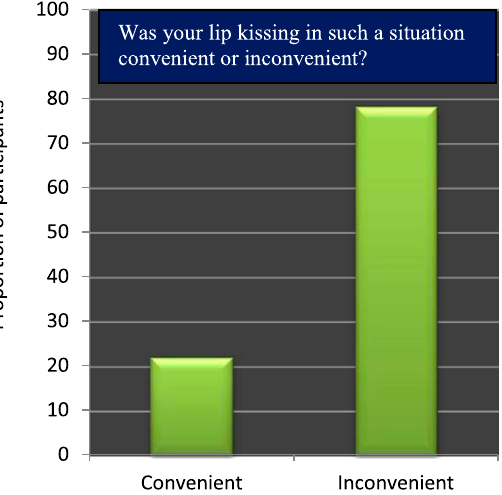
Figure 3. Proportions of participants who perceived kissing, with the two heads turned to the opposite direction (i.e., oriented at the same line in space), as convenient or